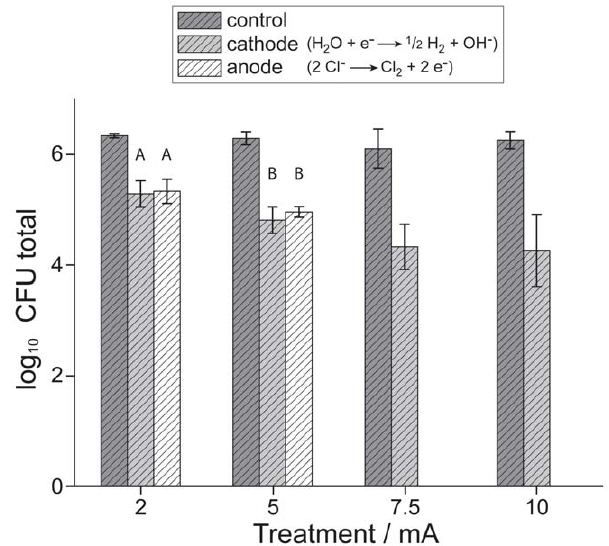
Figure 2. Reduction of E.Coli adhered on dental implants. Viable E. coli counts were reduced on implants after current treatment for 15 minutes (mean log 10 CFU (colony-forming units) values (N=3) and standard deviation). Pronounced differences arised for anodic (oxidative environment) and cathodic (alkaline environment) implants. A full disinfection could be obtained if an implant was used as anode and at a current of at least 7.5 mA. Same capital letters above data sets indicate no statistically significance (p .